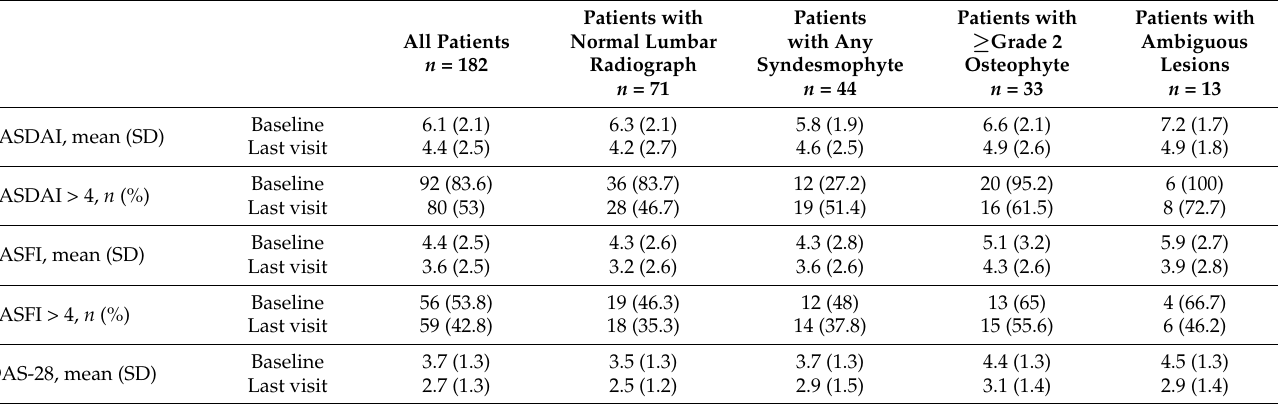
Table 2. Patient-reported outcomes of patients and CRP levels according to lateral lumbar radiogra- phy